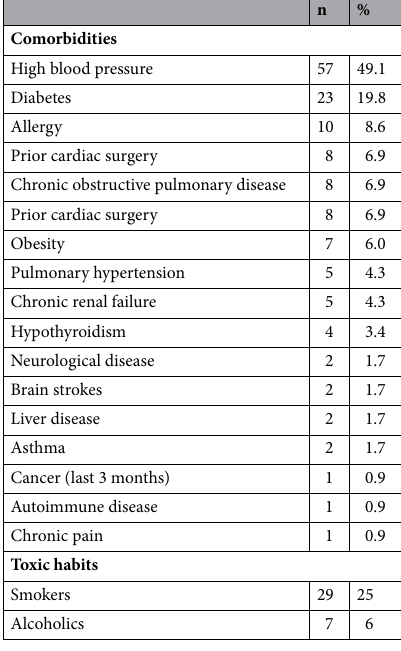
Table 1. Frequencies of comorbidities and toxic habits in the study sample.